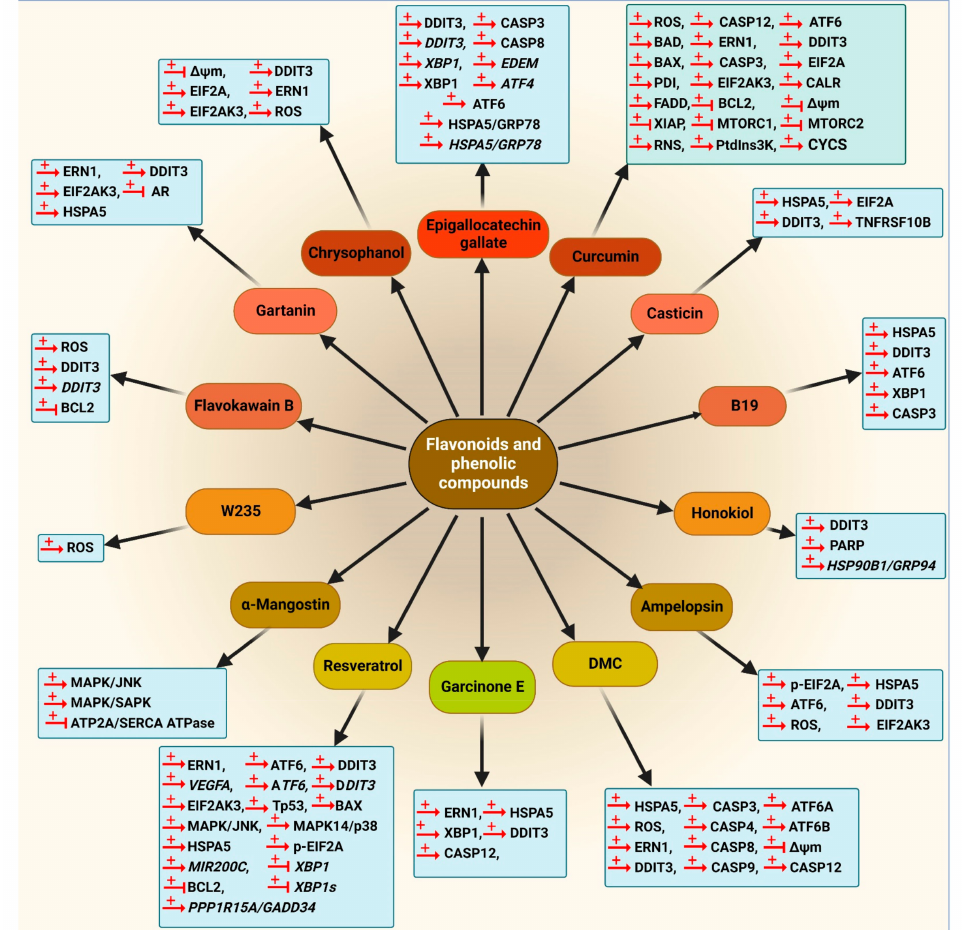
Figure 19. The schematic role of flavonoids and phenolic compounds on the proteins involved Figure 7. The schematic role of alkaloids on different proteins involved in the autophagy pathway. in the UPR and ER stress pathways. Most of the compounds mentioned in this part result in an Alkaloids regulate autophagy in different ways. Vincristine and carbazoles have been demonstrated increase in ER stress-related proteins, including HSPA5, EIF2AK3 and DDIT3. Moreover, they to inhibit autophagy by suppression of CD24, suppression of the PTEN-AKT-MTOR pathway and activate ATF6, PPP1R15A/GADD34, XBP1 splicing, DDIT3 and EDEM genes. Moreover, these enhancement of SSQTM1/p62. Other alkaloids induce autophagy via activation of AMPK, TSC2, compounds increase phosphorylation of MAPK/JNK, expression of CYCS, BAX and FADD, as well MAPK/JNK-AP-1 and BECN1, and enhance MYC/c-Myc, LC3-II and ATG7 expression. Moreover, as activation of caspases and upregulation of TNFRSF10B, triggering ROS generation. Suppression inhibiting the AKT-MTOR pathway has a key function in induced autophagy by alkaloids. Moreo- of the transcriptional activity of XBP1 via SIRT1 was reported in some cell lines treated with these ver, another alkaloid named tetrandrine induces autophagy by suppressing the WNT- CTNNB1/β - compounds. In one case, the inhibitory activity of the compound against AR was observed. Moreover, catenin pathway and decreasing MTA1 expression. → : Indicates activation or an increase in the mentioned protein expression. contrary to other compounds, resveratrol promotes cell death by inhibiting the transcriptional activity of XBP1s, which leads to impairment of the cell survival functions. → : Indicates activation or an increase in the mentioned protein expression. mentioned protein expression. +: means positive effect of the proteins on different pathways. The : Indicates deactivation or a decrease in the mentioned protein expression. − and +: Indicate the effect figure was created with BioRender.com. Licensing Right PA24OB7OP8, 21 November of the proteins on different pathways ( − means negative effect and + means positive effect). The figure was created with BioRender.com. Licensing Right VD24OB6Q8E, 21 November 2022.